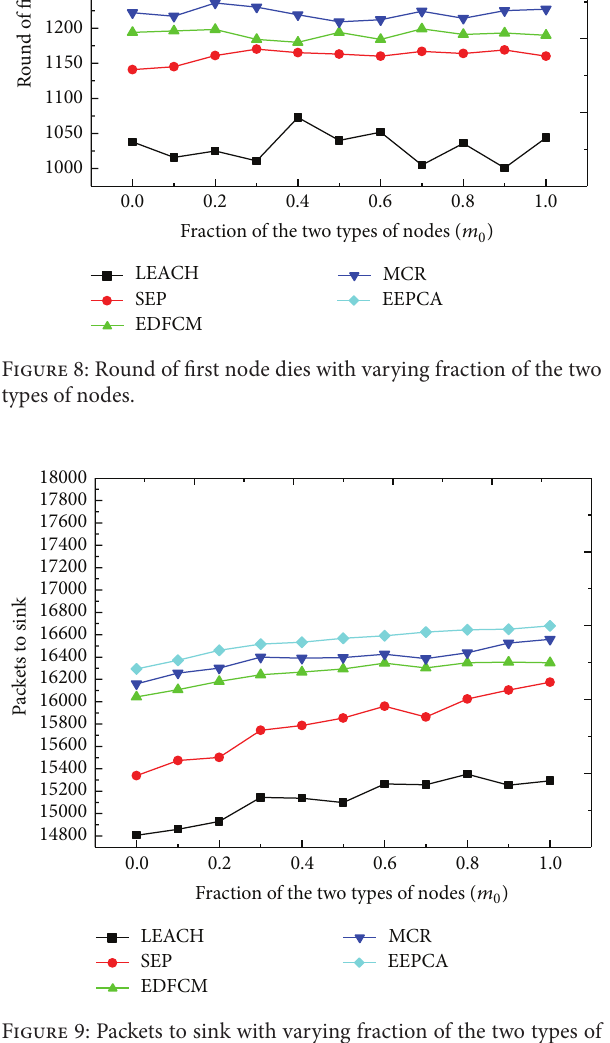
Figure 9: Packets to sink with varying fraction of the two types of